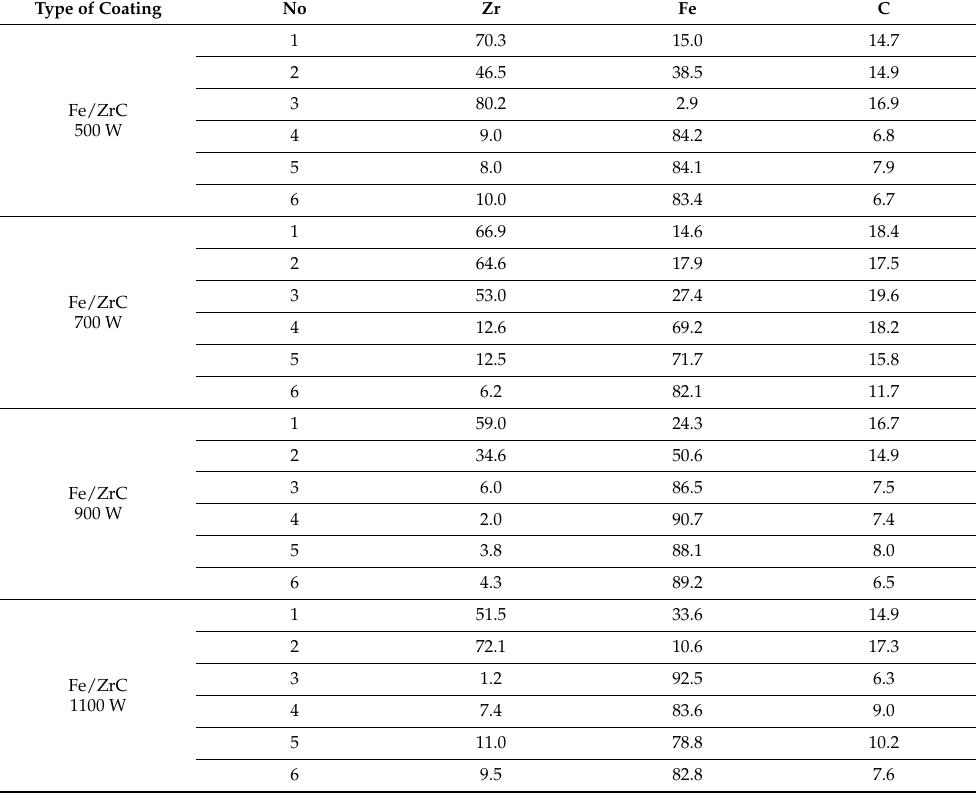
Table 2. Chemical composition (EDS) for Fe/ZrC coating produced using different laser beam power